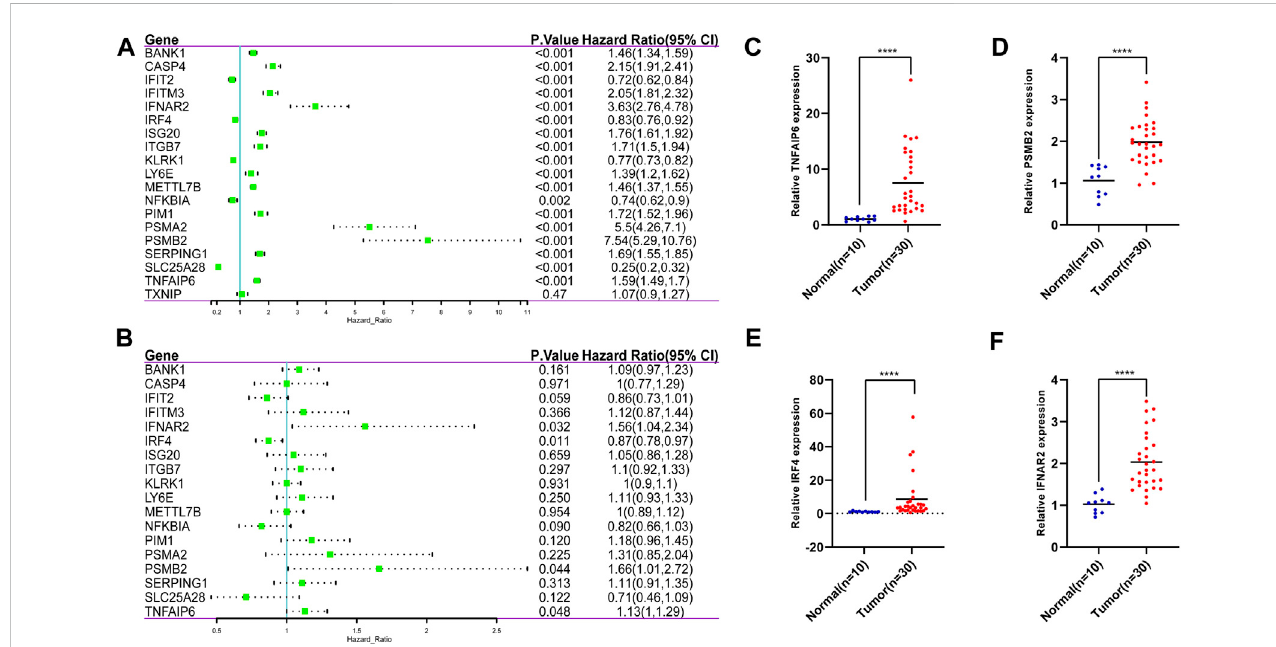
FIGURE 2 19 IFN- γ -associated geneswere selected by theLASSO regression analysis. (A) 18 IFN- γ - associated genes were selected by univariate Cox analysis. (B) 4 IFN- γ - associated genes were selected by multivariate Cox analysis. The expressions of TNFAIP6 (C) , PSMB2 (D) , IRF4 (E) and IFNAR2 (F) were signi fi cantly